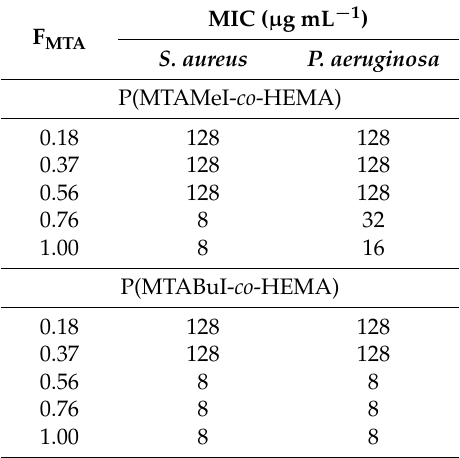
Table 3. Minimum inhibitory concentration (MIC) of the quaternized copolymers, P(MTAMeI- co -HEMA) and P(MTABuI- co -HEMA), against Gram-positive Staphylococcus aureus and Gram-negative Pseudomonas aeruginosa . MIC ( µ g mL − 1 ) F MTA S.